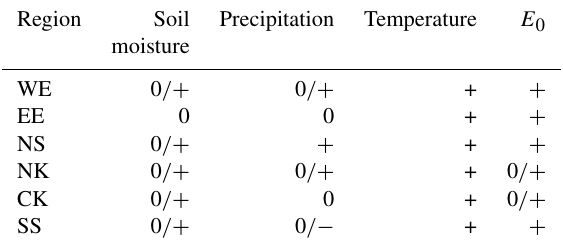
Table 5. Summary of synthesis results for each region and study variable. Note that “0” means no significant change, a “ + ” sign in- dicates a positive trend, and a “ − ” sign indicates a negative trend. The uncertainties associated with each result are depicted in Fig.